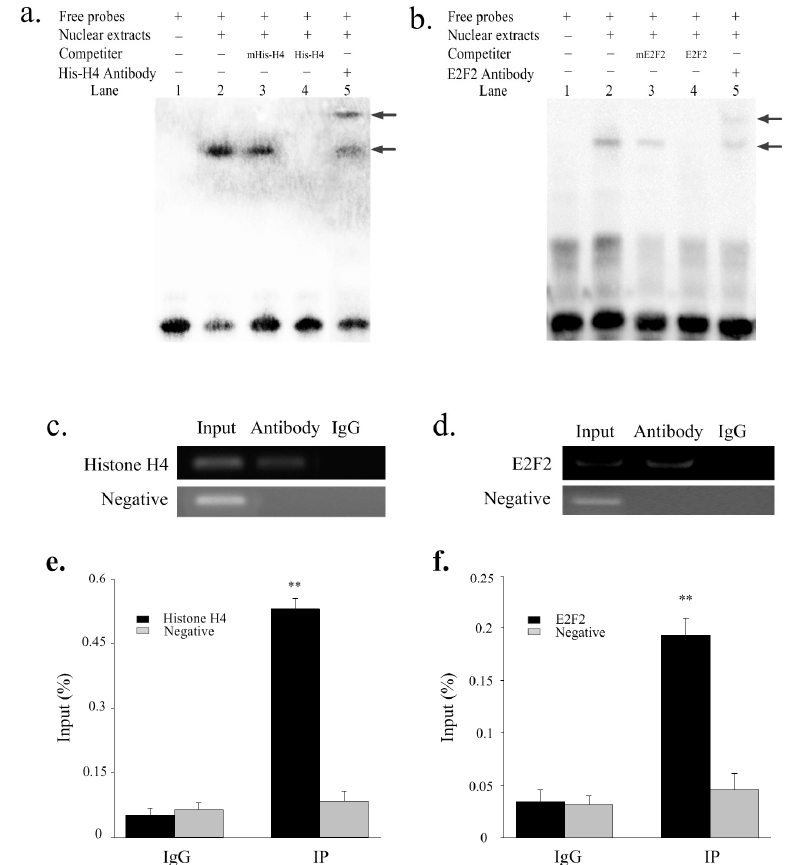
Figure 5. Electrophoretic mobility shift assay (EMSA) and ChIP analyses showing direct binding of histone H4 and E2F2 to the SIX1 promoter in vitro and in vivo . ( a , b ) Lane 1: 5 ′ -biotin labeled probe containing histone H4 and E2F2; Lane 2: histone H4 and E2F2 probes were incubated with nuclear extracts; Lane 3: the presence of histone H4 and E2F2 mutation probes (50×); Lane 4: histone H4 and E2F2 probes and nuclear extracts with 50-fold unlabeled oligonucleotides; Lane 5: histone H4 and E2F2 probes and nuclear extracts with 10 μ g of anti-histone H4 or anti-E2F2 antibodies. The arrows mark the primary complex and super-shift brand. ( c , d ) ChIP-PCR products were analyzed with the input and immunoprecipitated products for histone H4 and E2F2. The enrichment of DNA fragments in samples immunoprecipitated with histone H4 ( e ) and E2F2 ( f ) antibodies via ChIP-qPCR. Normal rabbit IgG and an intragenic DNA fragment of SIX1 exon 2 were used as negative controls. “**” p < 0.01. Error bars represent the SD ( n = 3).